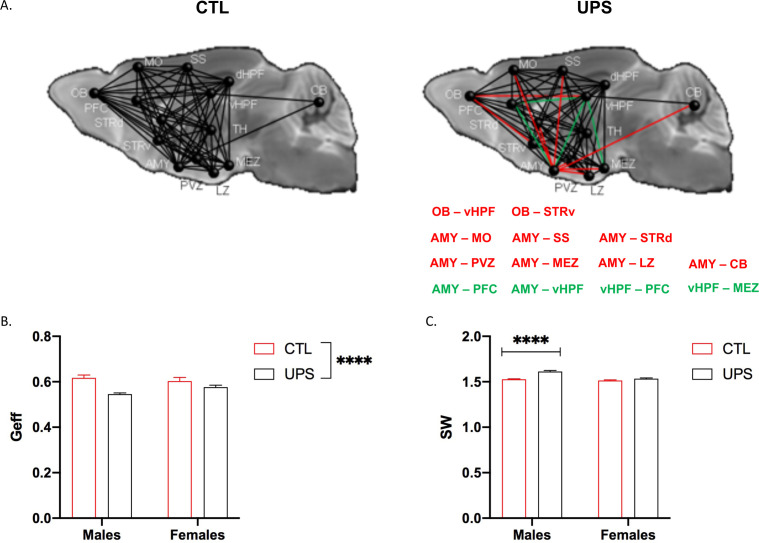
Global connectivity using an expanded cohort of animals (n = 12–13 per rearing and sex, total n = 49 mice).(A) Schematic representation of global connectivity for control (CTL) and unpredictable postnatal stress. Red lines indicate reduced connectivity and green lines indicate increased connectivity compared to CTL group. (B) Global efficiency (Geff) showed a significant effect of rearing (F (1, 45)=18.68, p<0.0001), no significant effects of sex (F (1, 45)=0.53, p=0.47), and a trend for interaction (F (1, 45)=3.92, p=0.054). (C) Small-worldness (SW) showed significant effects of rearing (F (1, 45)=38.38, p<0.0001), sex (F (1, 45)=29.6, p<0.0001), and interaction (F (1, 45)=14.13, p=0.0005), with Sidak’s post-hoc analysis showing significant increase in males (p<0.0001) but not females (p=0.18). Mean and SEM, ****p<0.00001. Abbreviations: amygdala (AMY), cerebellum (CB), dorsal hippocampus (dHP), dorsal striatum (STRd), lateral hypothalamic zone (LZ), medial hypothalamic zone (MEZ), motor (MO), olfactory bulb (OB), periventricular zone (PVZ), prefrontal cortex (PFC), somatosensory cortex (SS), thalamus (TH), ventral hippocampus (vHP), ventral striatum (STRv).Figure 11—source data 1.Raw data for Figures 11 and 12.